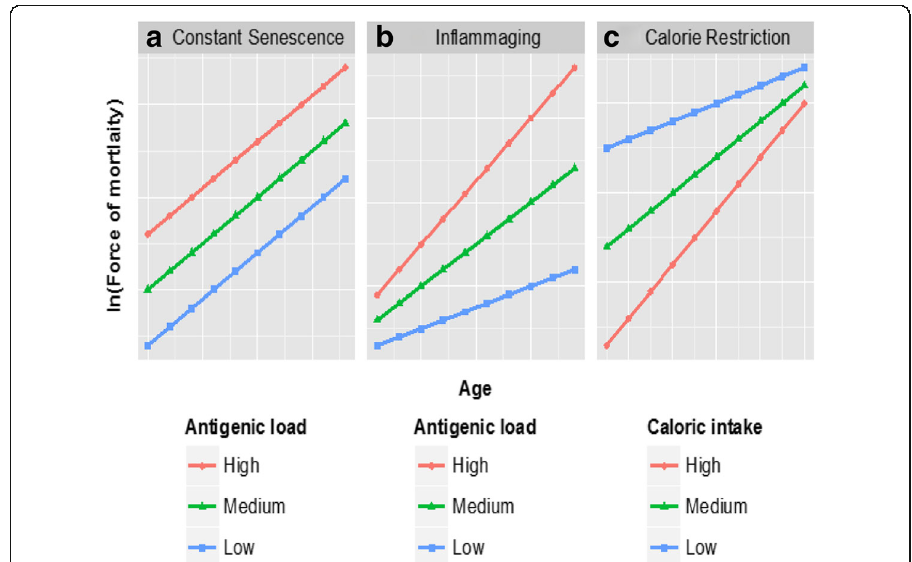
Fig. 1 Three hypotheses on the determinants of senescence. Note : The curves represent the evolution of the individual force of mortality after the aging onset. Sources : Authors ’